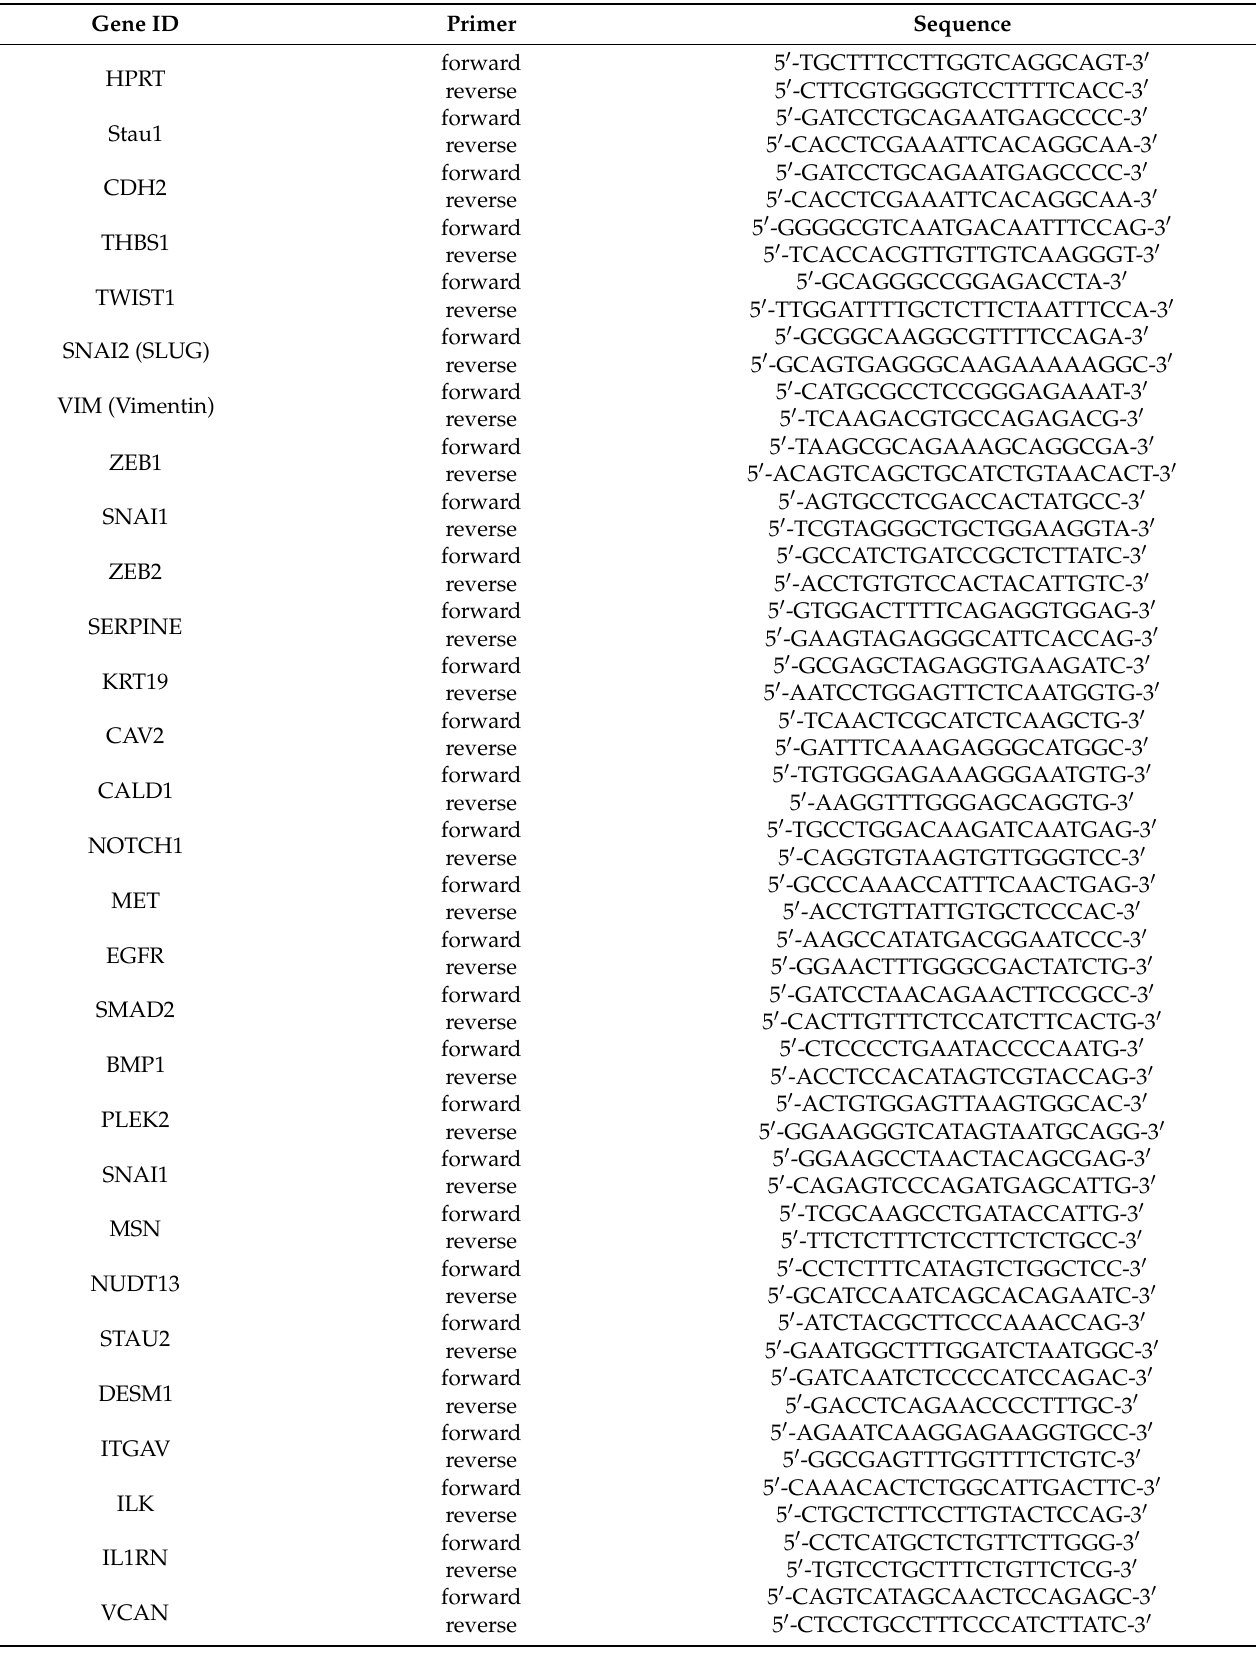
Table 3. RT-qPCR